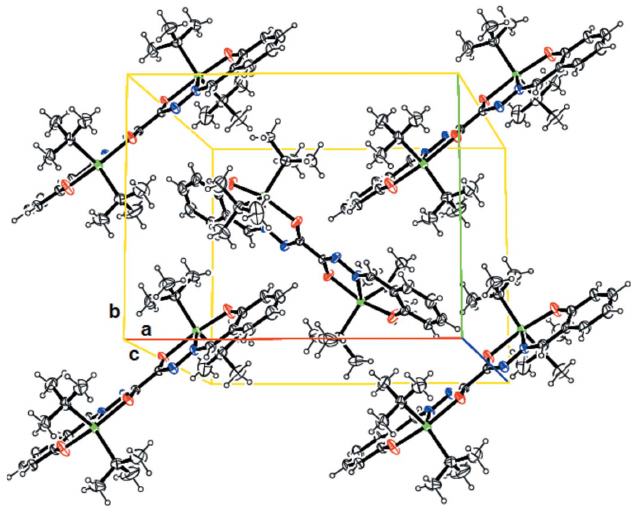
Figure 2 A view of the crystal packing of the title